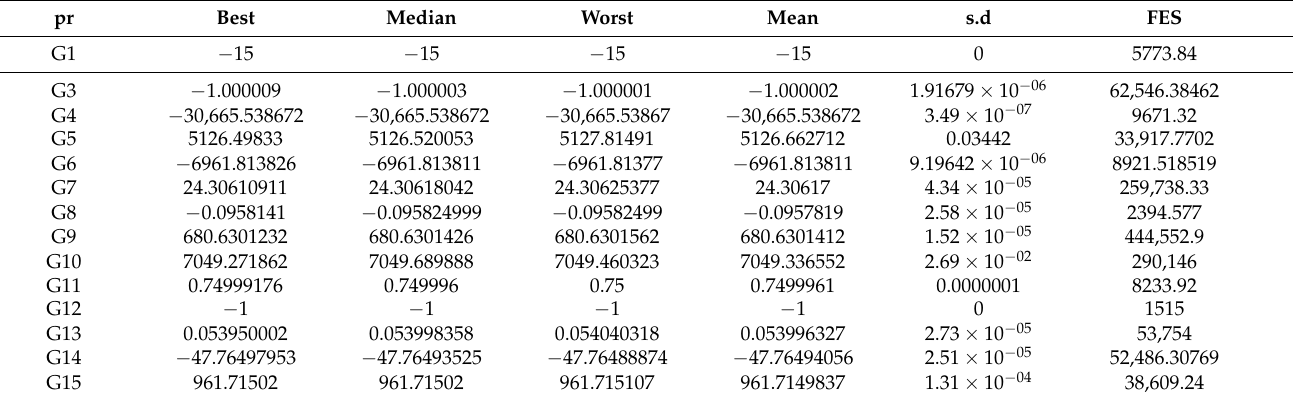
Table 8. Statistical results of “GHMSA” Algorithm for first set of test problems and four mechanical engineering